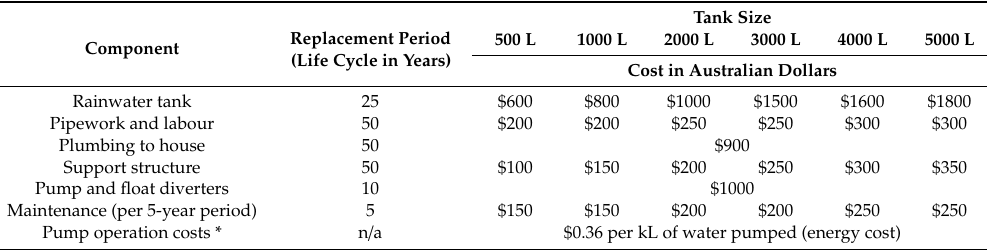
Table 3. Components and input assumptions for life cycle costing using the capital recovery method (all costs in Australian Dollars).